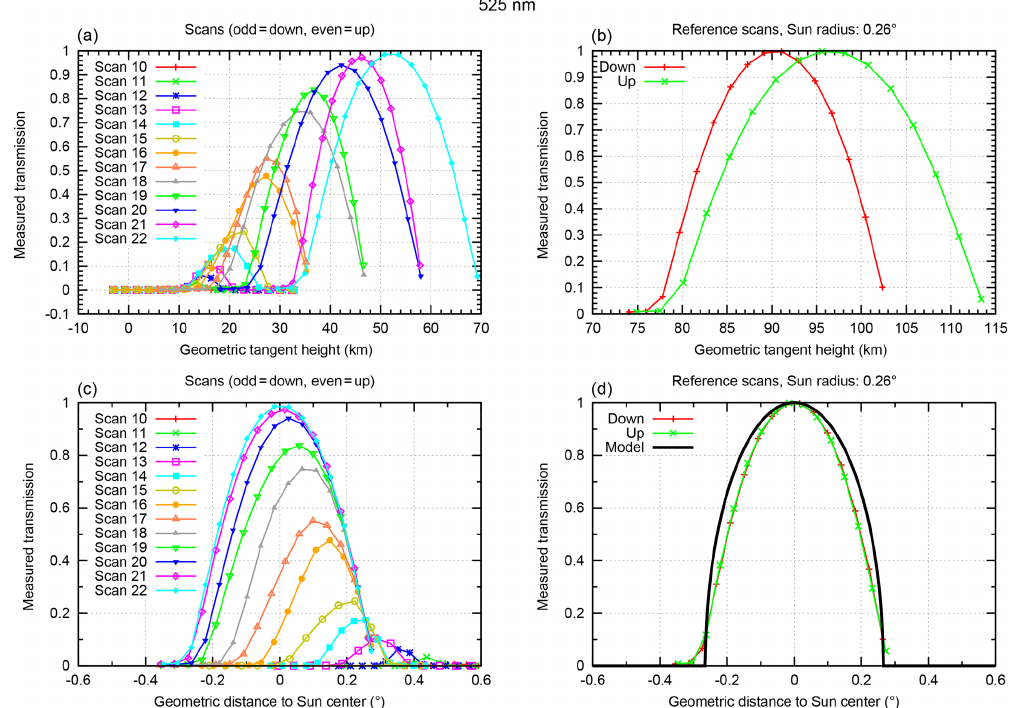
Figure 3. SCIAMACHY transmissions at 525nm. (a) Measured transmission as function of tangent altitude for different scans. (b) Reference transmissions as function of tangent altitude for up- and downscans. (c) Measured transmission as function of distance to Sun centre. (d) Transmissions as function of distance to Sun centre and corresponding